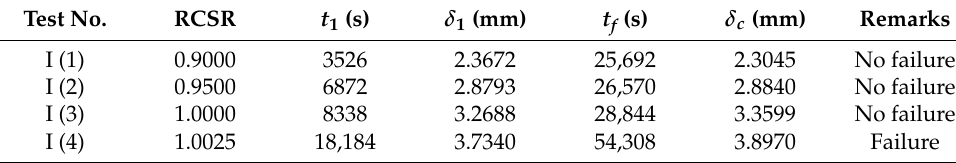
Figure 3. Overall experimental procedure for Test I: ( a ) application of constant creep load for residual- state creep stress ratio (RCSR) values from 0.9000 to 1.0025; ( b ) automatically recorded data from the creep test; ( c ) analysis results for the interpretation of different creep stages. Table 1. Residual state creep tests summary for Test